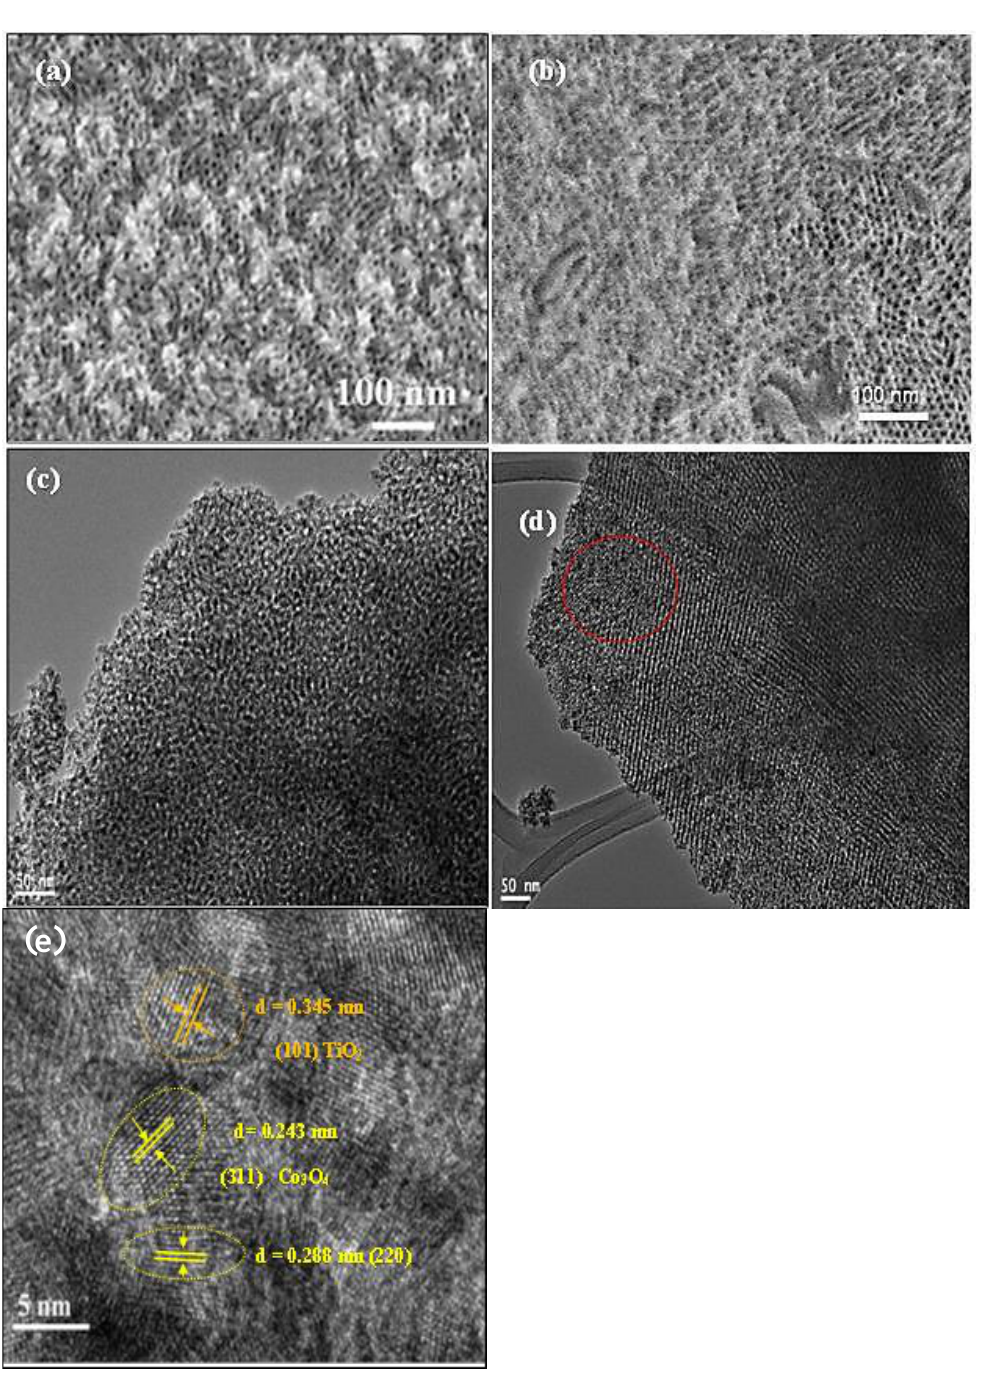
O (3)/ lsm -TiO and ( b ) Co O (3)/ hm -TiO 3 4 2 3 4 , ( d ) Co O (3)/ hm -TiO , and ( e ) high resolution TEM of Co 2 3 4 2 TiO hybrid. 2